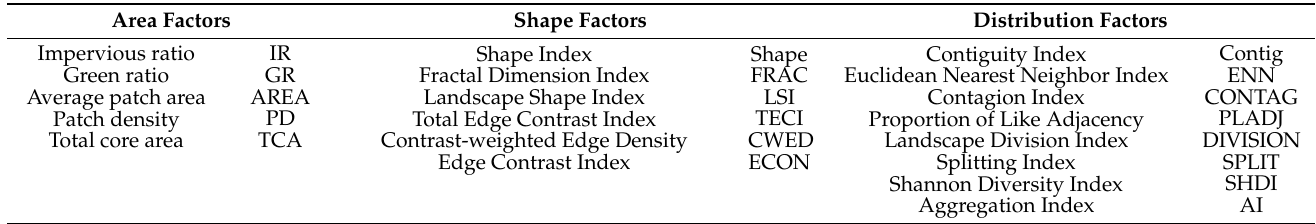
Table 2. Landscape